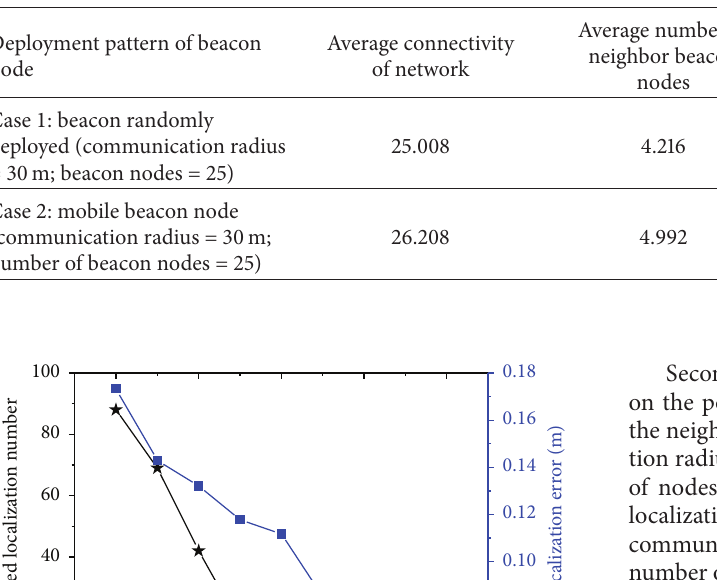
Table 1: Contrast of two kinds of localization scheme.